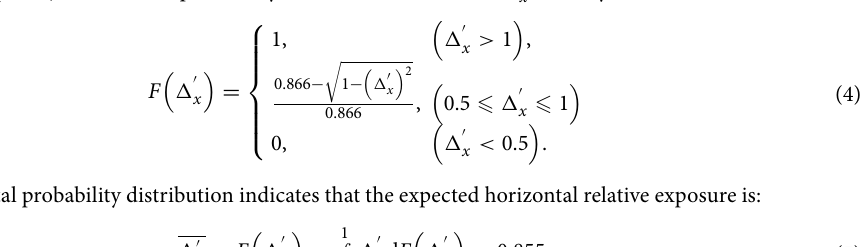
Horizontal relative exposure. The disturbance in sandy silt flowing through the particles creates swirling structures between them in the process, which not only exerts a vertical force on the particles but also causes horizontal lift and drag forces between the particles. As a result, the particle arrangement is different, i.e., the ratio of horizontal particle transport distance to particle radius is the horizontal relative exposure � ′ x the disturbance layer in thick slurry, (cid:31) ′ x among the particles is the same as (cid:31) ′ z . Therefore, all particles are assumed to be closely arranged. In addition, (cid:31) ′ x and (cid:31) ′ z change with the changes of particle positions. According to the analysis of probability distribution, the correlation between (cid:31) ′ x and (cid:31) ′ z 12 can be further defined as: